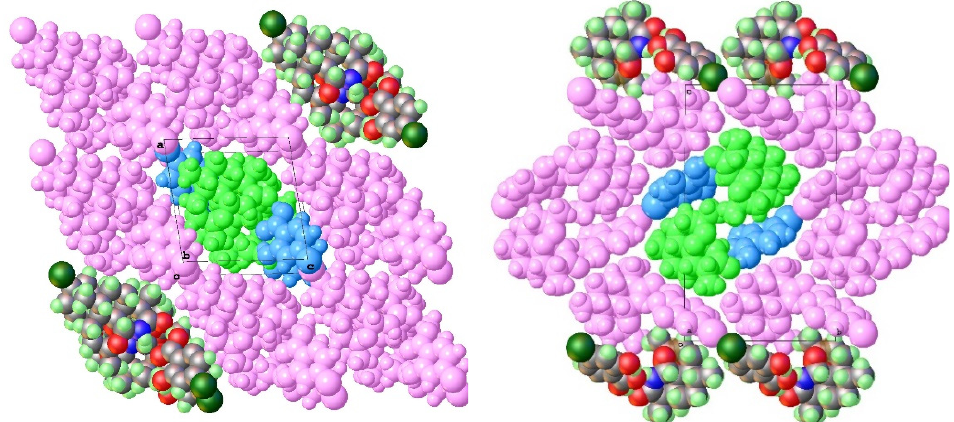
Figure 9. Packing of 11-Aza:4-Cl-SalA type-I ( left ) along [010] and type-II ( right ) along [100] showing